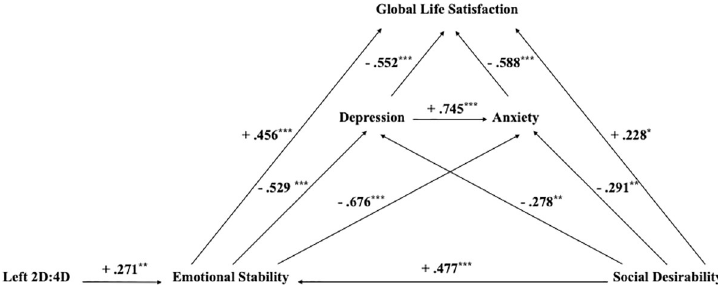
Fig 1. Main associations found related to emotional stability as personality trait. Arrows indicate that there is a significant correlation between the two linked constructs and the value indicates the Pearson’s correlation coefficient between them. �� p � .01; ��� p � .001.